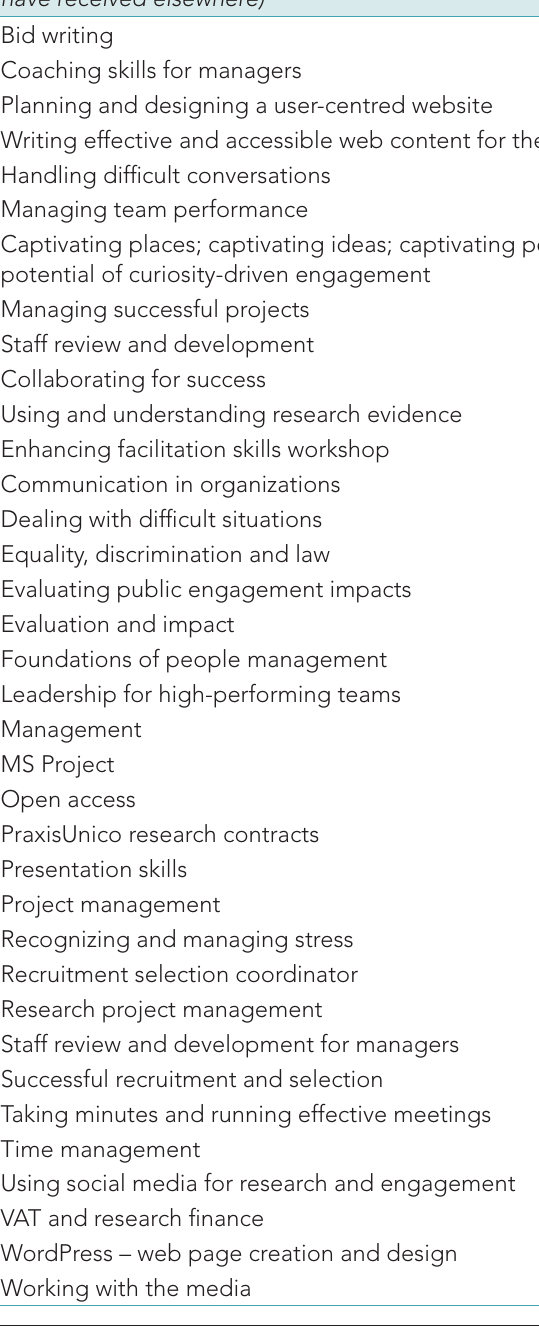
Table 2: The formal training undertaken by PEPUR network members What training have you received to support you in carrying out your role? (Include training that you have received for this role and training